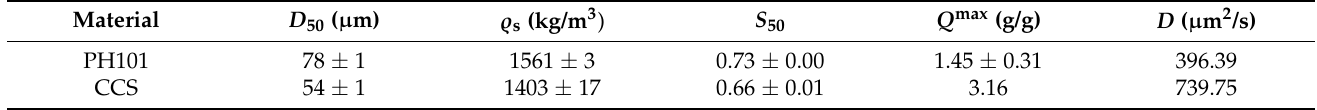
Table 1. Values of the particle properties: size ( D 50 ), true density ( (cid:36) s ), shape ( S 50 ), liquid absorption ( Q max ), and diffusion coefficient ( D ) of the two materials (obtained from [32]).